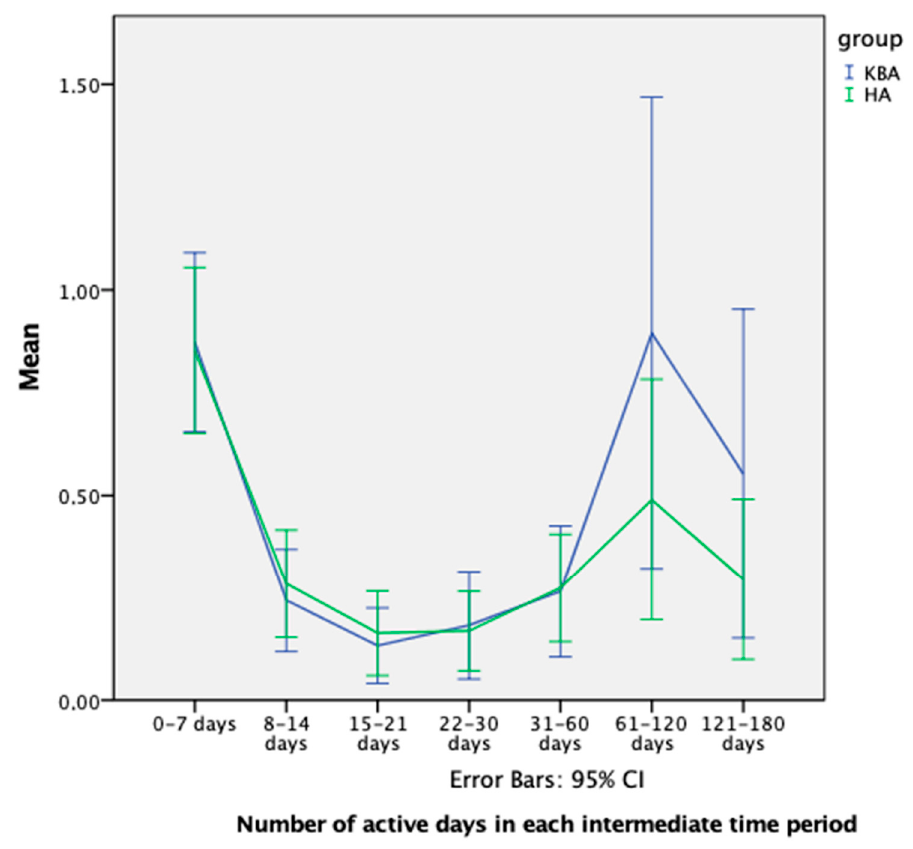
Figure 5. Evolution of the number of active days (higher is better).